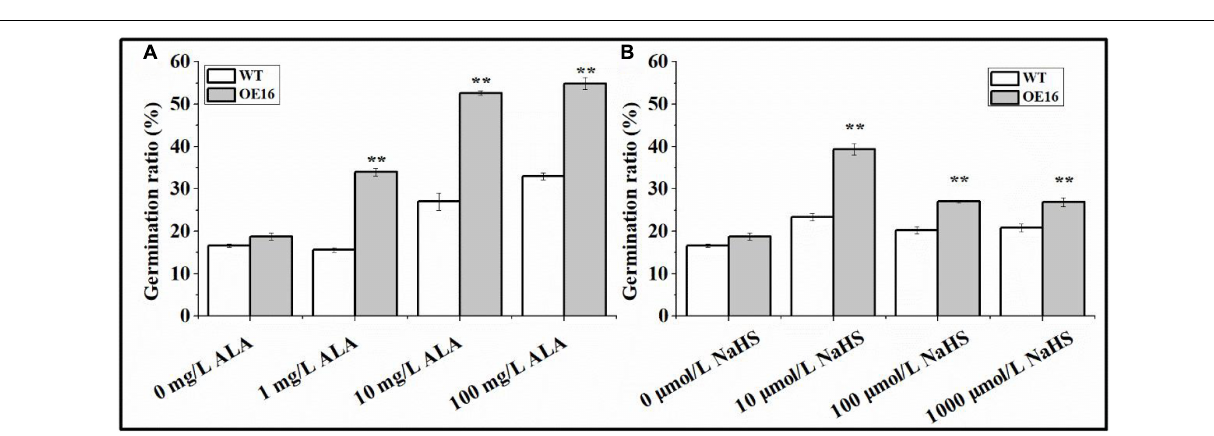
lines were ∼ 2-fold higher at 2 h than in the WT: the levels in OE9 and OE16 plant increased by 86.7 and 96.6%, respectively, ( Figure 10 ). The H 2 S content of WT plants then increased to the